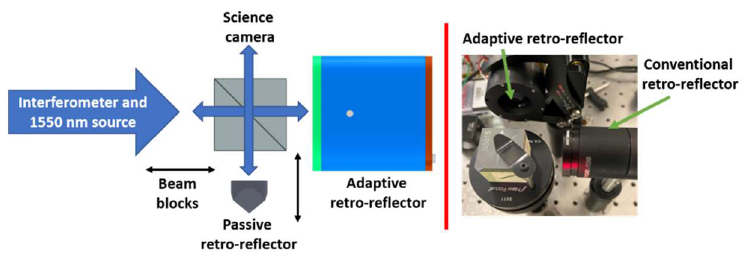
Figure 5. ( Left ) Layout of the optical testing setup. ( Right ) Picture of optical devices used for meas- urements.